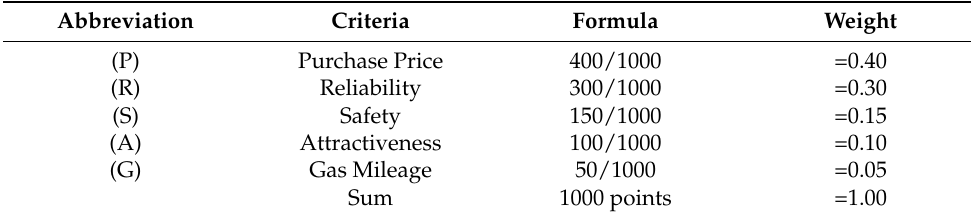
Table 2. DAT weight